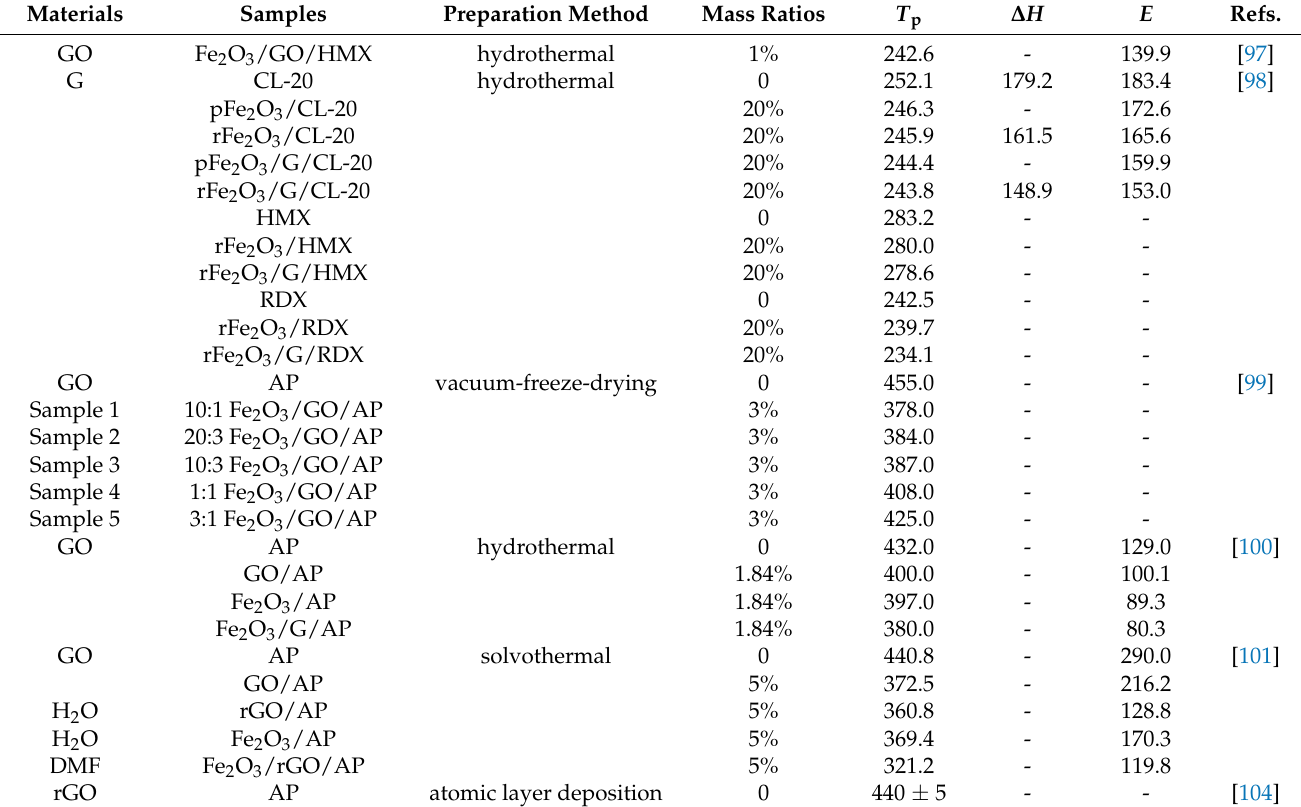
Table 3. Summary of thermal behavior parameters of carbon composites